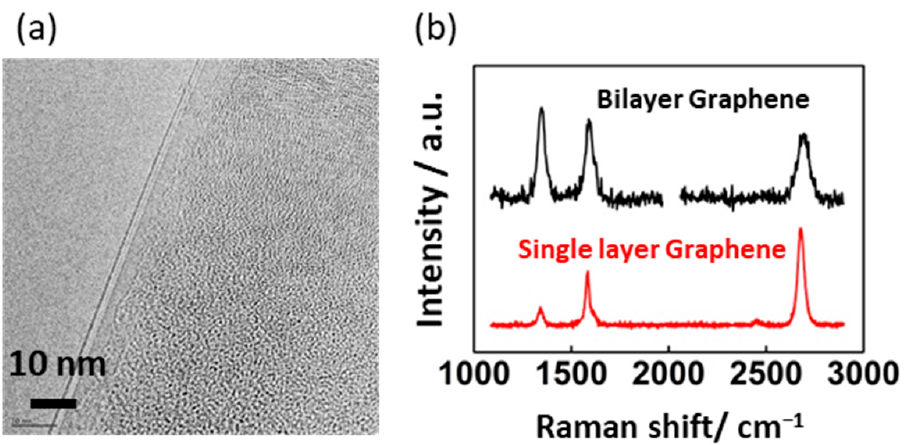
Figure 1. ( a ) Transmission electron microscopic image of bilayer graphene. ( b ) Raman scattering spectra of the graphene electrodes. Single-layer and bilayer graphene are represented by red and black curves, respectively.